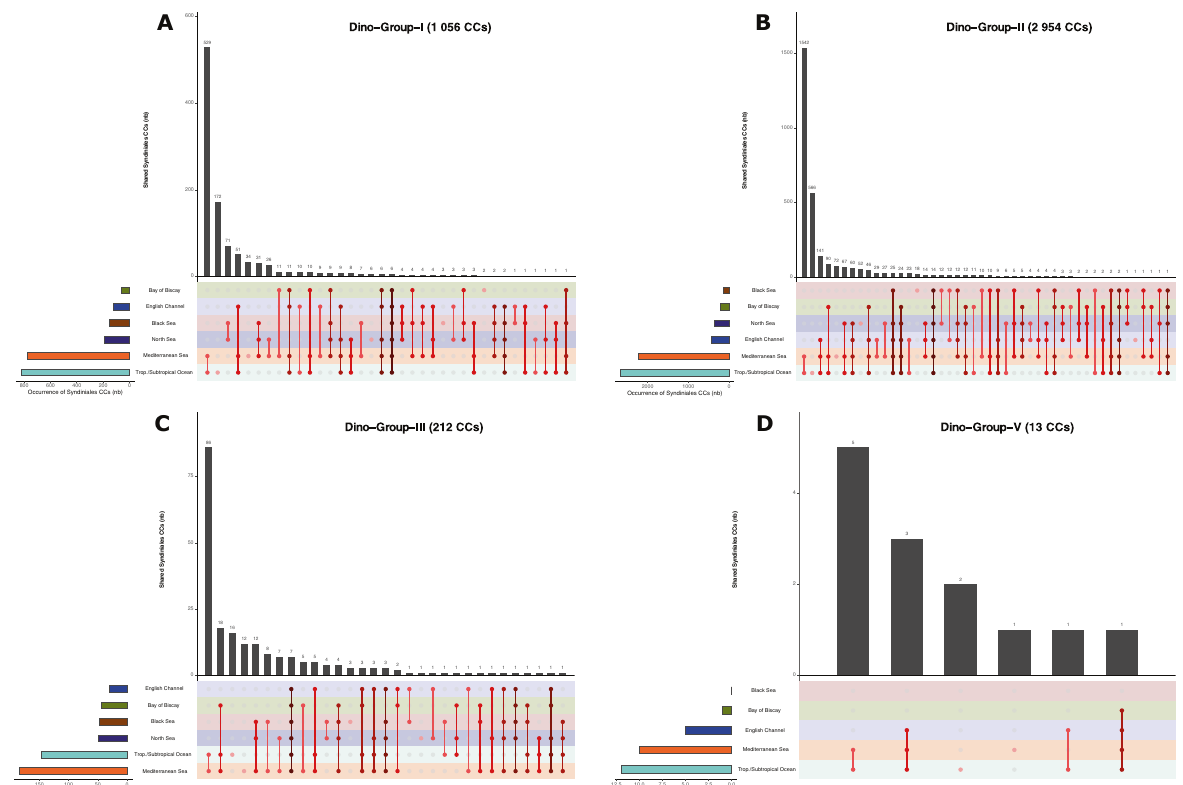
Fig. 2 Geographical distribution patterns of Connected Components (CCs) among Syndiniales orders unassigned at genus taxonomic level. The number of CCs (y axis and above each bar) within each Syndiniales order (Dino-Group-I, II, III and V; A , B , C and D respectively) is represented according to their patterns of occurrence across the 6 sea regions de fi ned in our metadata (Supplementary Fig. S2). Results are presented in ascending order across the x axis. The 4245 CCs containing only unassigned sequences at genus level within each order of Syndiniales were selected for this analysis. The non-assigned Syndiniales order “ Unknown ” , composed of 10 CCs (Supplementary Fig. S7B), is not depicted as it follows only 2 patterns: 9 CCs shared between the Mediterranean Sea and Trop./Subtropical Ocean and 1 CC shared between the Mediterranean Sea, Trop./Subtropical Ocean and North Sea. Syndiniales order Dino-Group-IV contained only assigned sequences (at genus level) and was thus not included in the plot. The occurrence color code indicates the different sea regions, while the red gradient indicates the geographical distribution range of CCs (i.e., light red: CC found in 1 sea region; bordeaux: CC found across the 6 sea regions). (N.b. The number of sampled stations is variable between sea regions with a higher number of stations sampled in Subtropical ocean (122 stations) and Mediterranean sea (35 stations). The other 4 sea regions are represented by samplings at a single station. Also Subtropical ocean and Mediterranean sea include samplings located between 200 m and 4000 m deep. North sea and Black sea samples are from surface, DCM and anoxic layers. The English Channel and Bay of Biscay include only surface samples (Supplementary Table